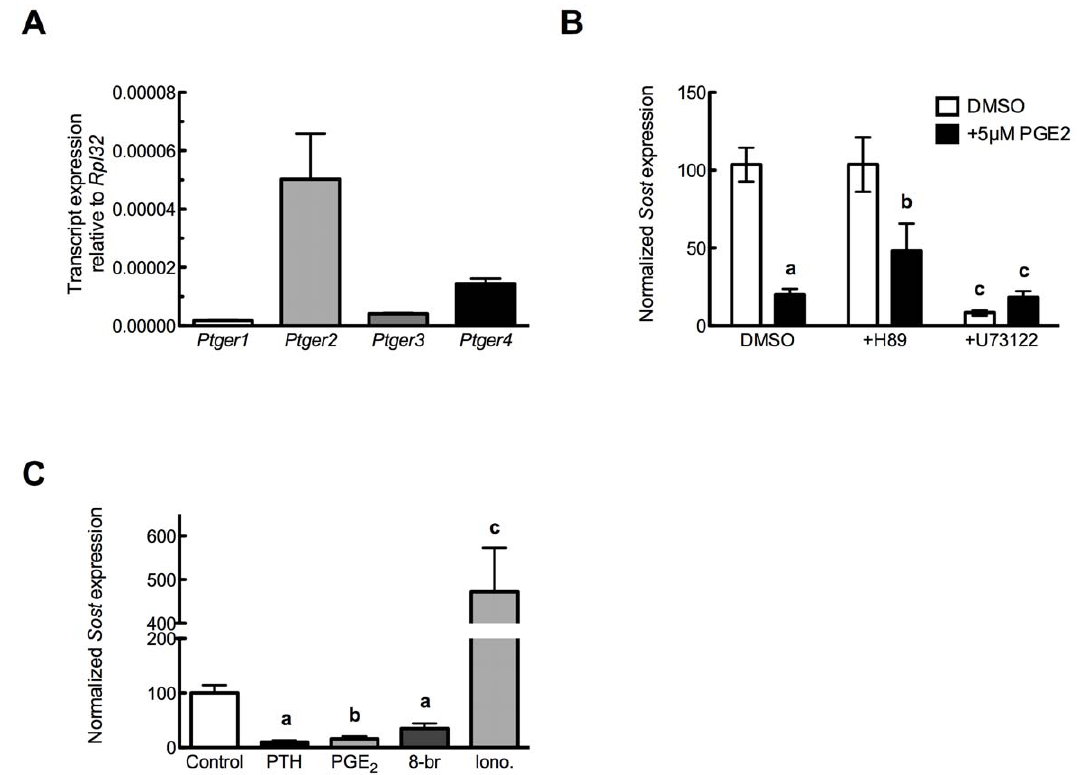
Figure 3. PGE 2 receptor expression and influence of PGE 2 selective agonists upon Sost expression. ( A ) UMR106.01 cells analyzed for Ptger1 , Ptger2 , Ptger3 , and Ptger4 transcript expression by qPCR. Data are normalized to Rpl32 . n=4 samples. ( B ) UMR106.01 cells were cultured with DMSO as vehicle control, 100 nM hPTH(1–34), 5 m M PGE 2 in the presence and absence of inhibitors of protein kinase A (H-89, 2.5 m M) or phospholipase C (U73122, 10 m M), for 3 hours. Total RNA was analyzed for Sost and normalized to Rpl32 . n=4–8 samples. Compared to solvent control, a indicates p , .001 and b indicates p , 0.05; c indicates p , .001. ( C ) UMR106.01 cells were cultured with DMSO as vehicle control, 100 nM hPTH(1–34), the cell-permeant cyclic AMP analogue 8-br-cAMP (1 mM) or the calcium ionophore ionomycin (1.3 m M) for 3 hours, after which total RNA was collected and analyzed for Sost and Rpl32 . n=4–8 samples. Versus Control, a indicates p , 0.05, b indicates p , 0.01, and c indicates p , 0.001.